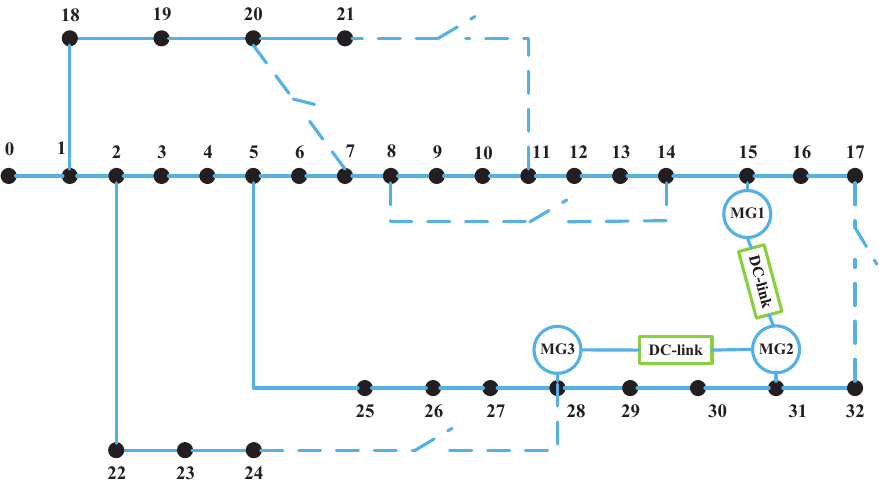
Figure 5. IEEE 33-node test system containing multi-microgrid connected via